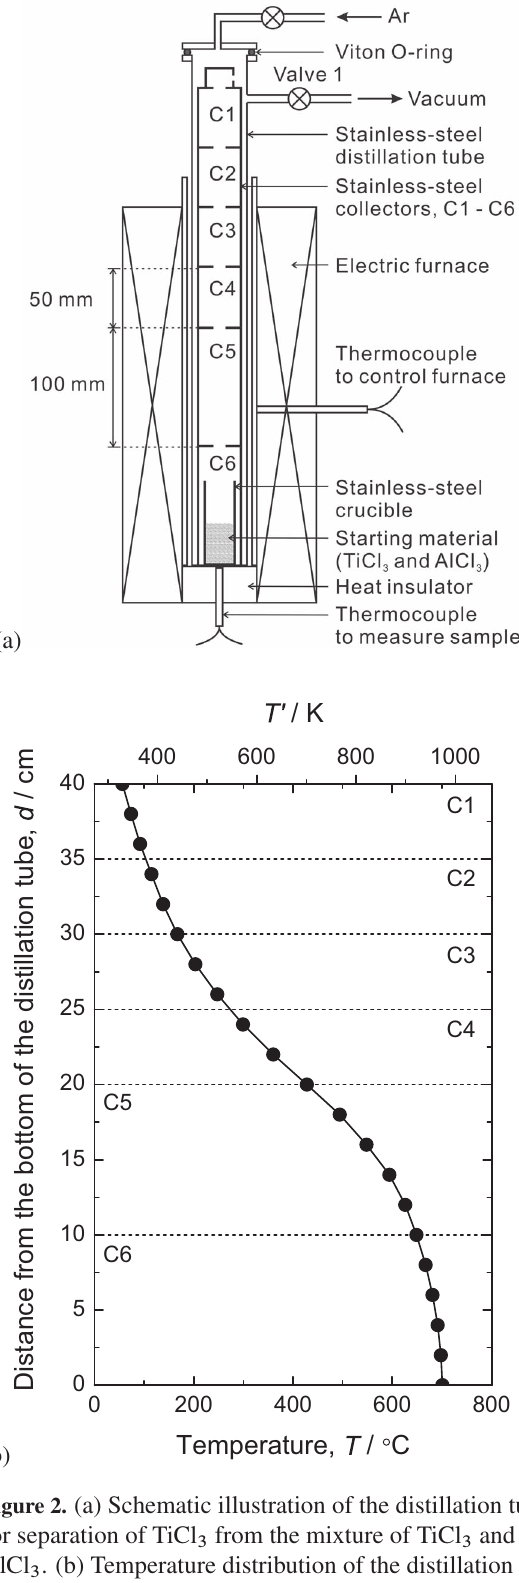
Figure 2. (a) Schematic illustration of the distillation tube for separation of TiCl 3 from the mixture of TiCl 3 and AlCl 3 . (b) Temperature distribution of the distillation tube. Dashed lines indicate condensing zones divided by the col-